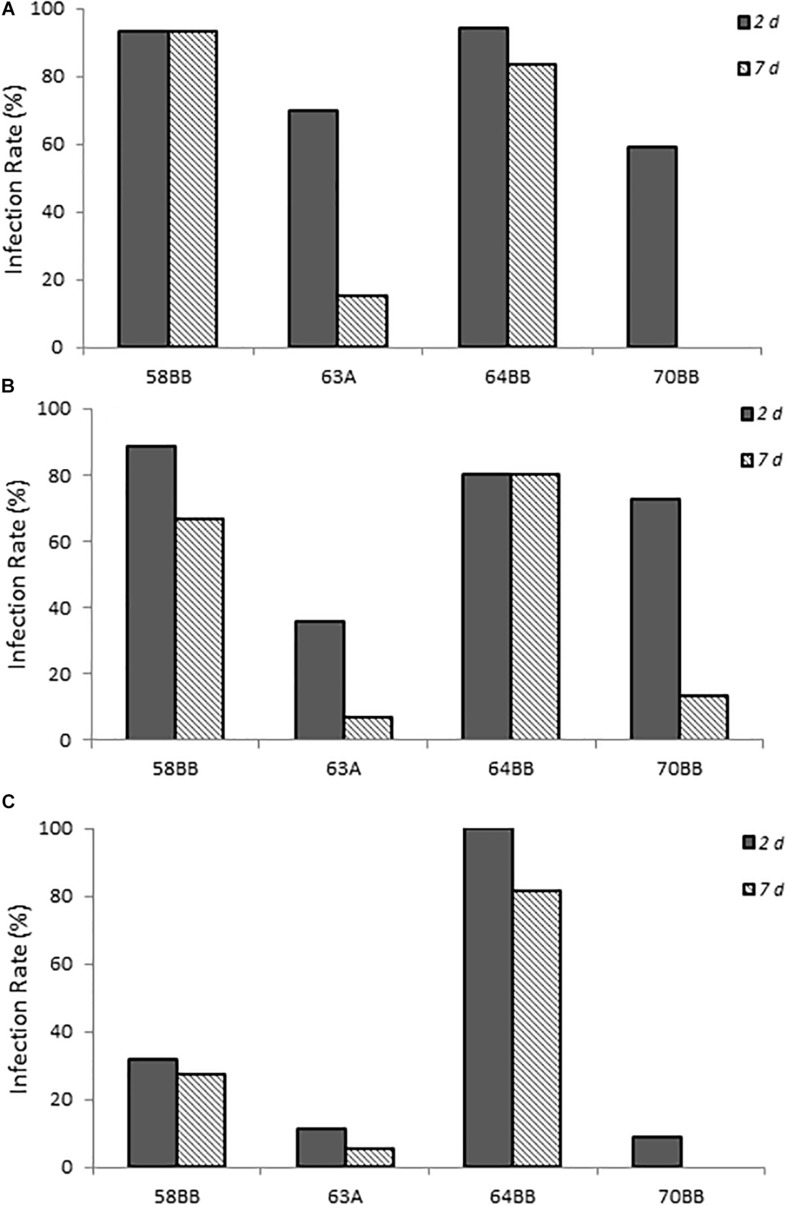
Infection rates of environmental isolates of Campylobacter spp. (A–C) show chicks infected with Campylobacter spp. environmental isolates at doses A–C, respectively, as described in Supplementary Table S1. Percent infected was determined by dividing the number of infected chicks by the total number of chicks inoculated with the various Campylobacter species. Chicks were considered infected if fecal samples collected at the various times were positive for Campylobacter spp. as determined by using the passive-filter plating as described in section “Materials and Methods.”